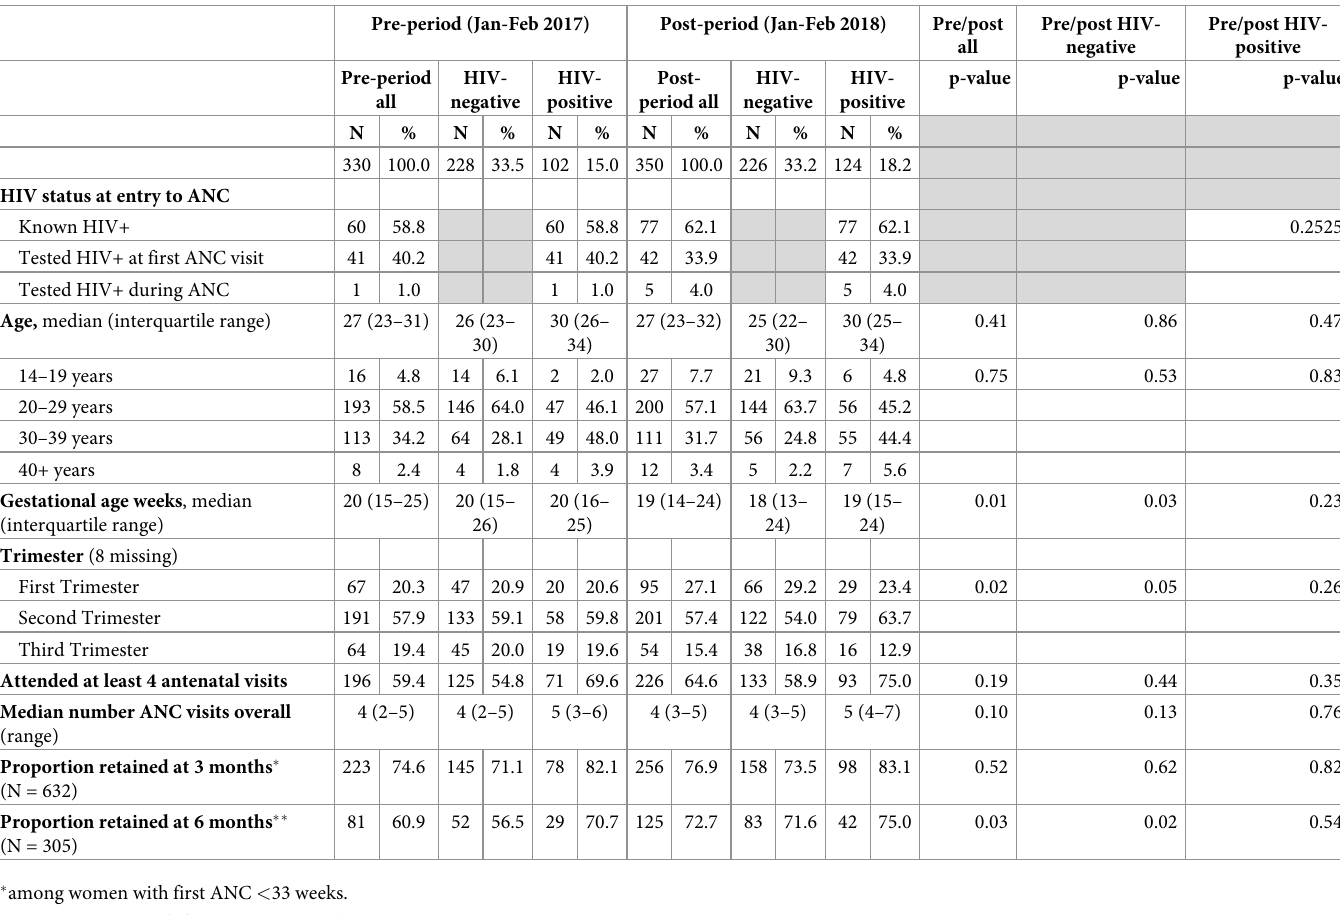
Table 3. Characteristics and retention among pregnant women newly entering ANC at two health facilities in Eswatini in the pre (Jan-Feb 2017) and post (Jan-Feb 2018) intervention periods (N = 680).